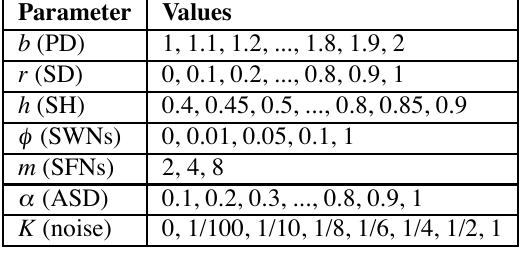
Table 4. Parameter values used in the simulations.